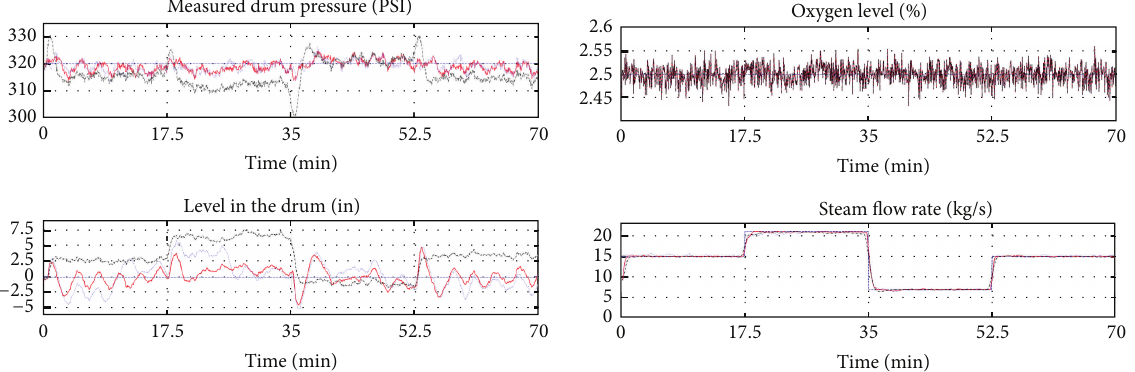
Figure 7: Response of the boiler using the three controllers (red solid line: proposed controller; blue dotted line: conventional PSO based controller; black dashed dotted line: linear MPC; and blue dashed line: reference trajectory).